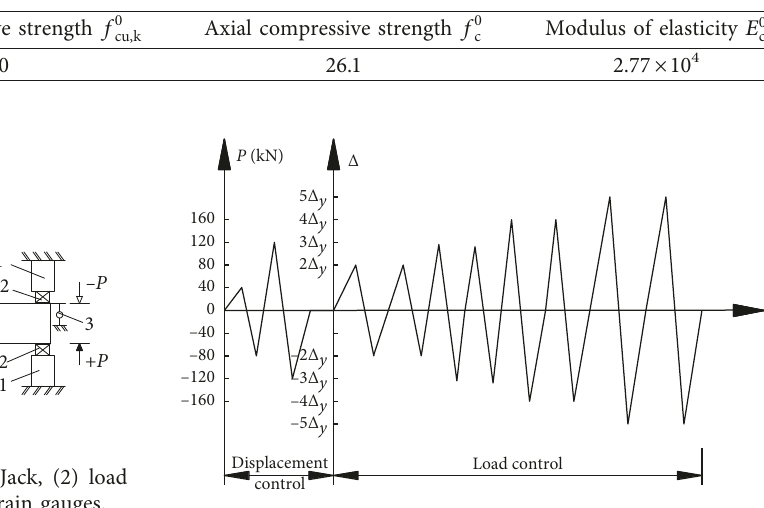
Table 3: Properties of concrete (unit: N/mm 2 ).